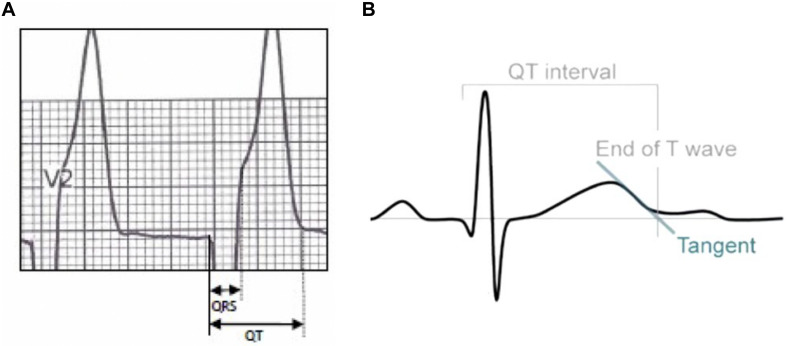
In normal T wave morphologies, the termination of the T wave was taken to be the point of maximal change in the slope as the T wave merges with the baseline (A). If there was any difficulty in determining the end of the T wave, the end point is considered as the intersection between the tangent of steepest slope of the T wave and the isoelectric line (B).